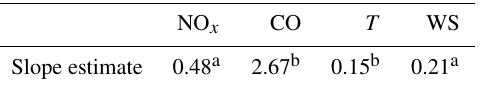
Table 3. Statistical results of the Mann–Kendall test and Theil–Sen trend estimate for daily mean values of NO x , CO mixing ratios, temperature ( T ) and wind speed (WS) in September and October at the Dongtan (DT) site, a remote rural site near Sheshan Island (SSI), during the 2012–2017 period. The units of the calculated slopes